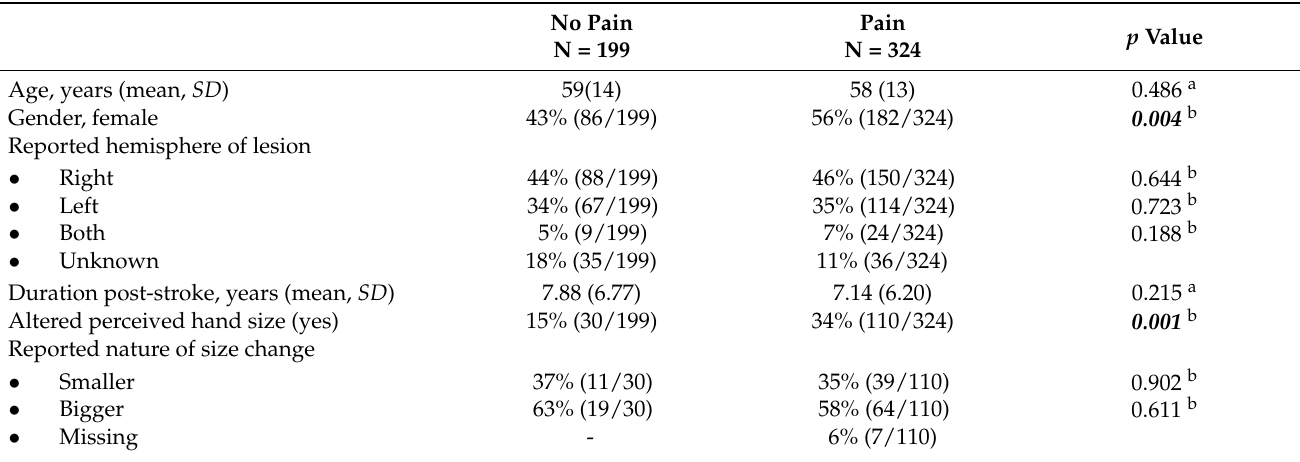
95%CI 1.844, 4.547). Nominated gender did not influence likelihood of reporting